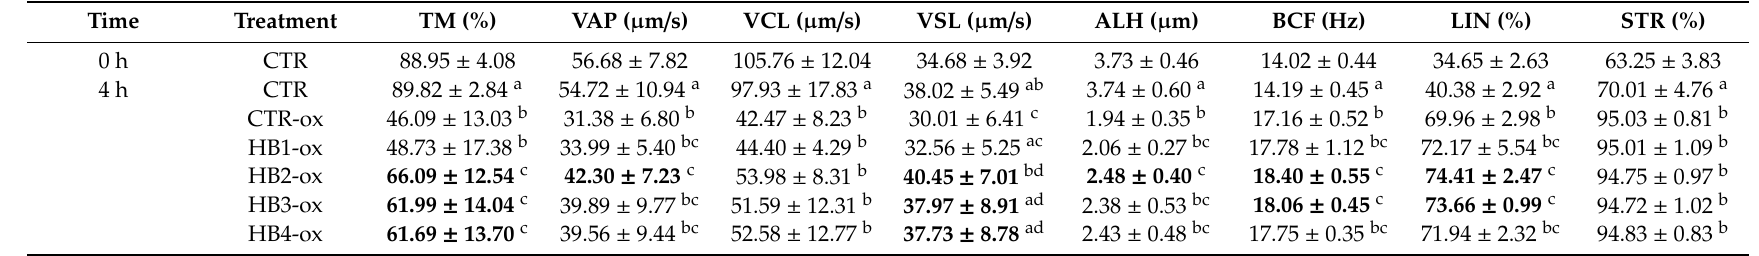
Table 1. Motility and kinetic parameters of boar sperm samples submitted to oxidative stress and supplemented with honeybush extract.